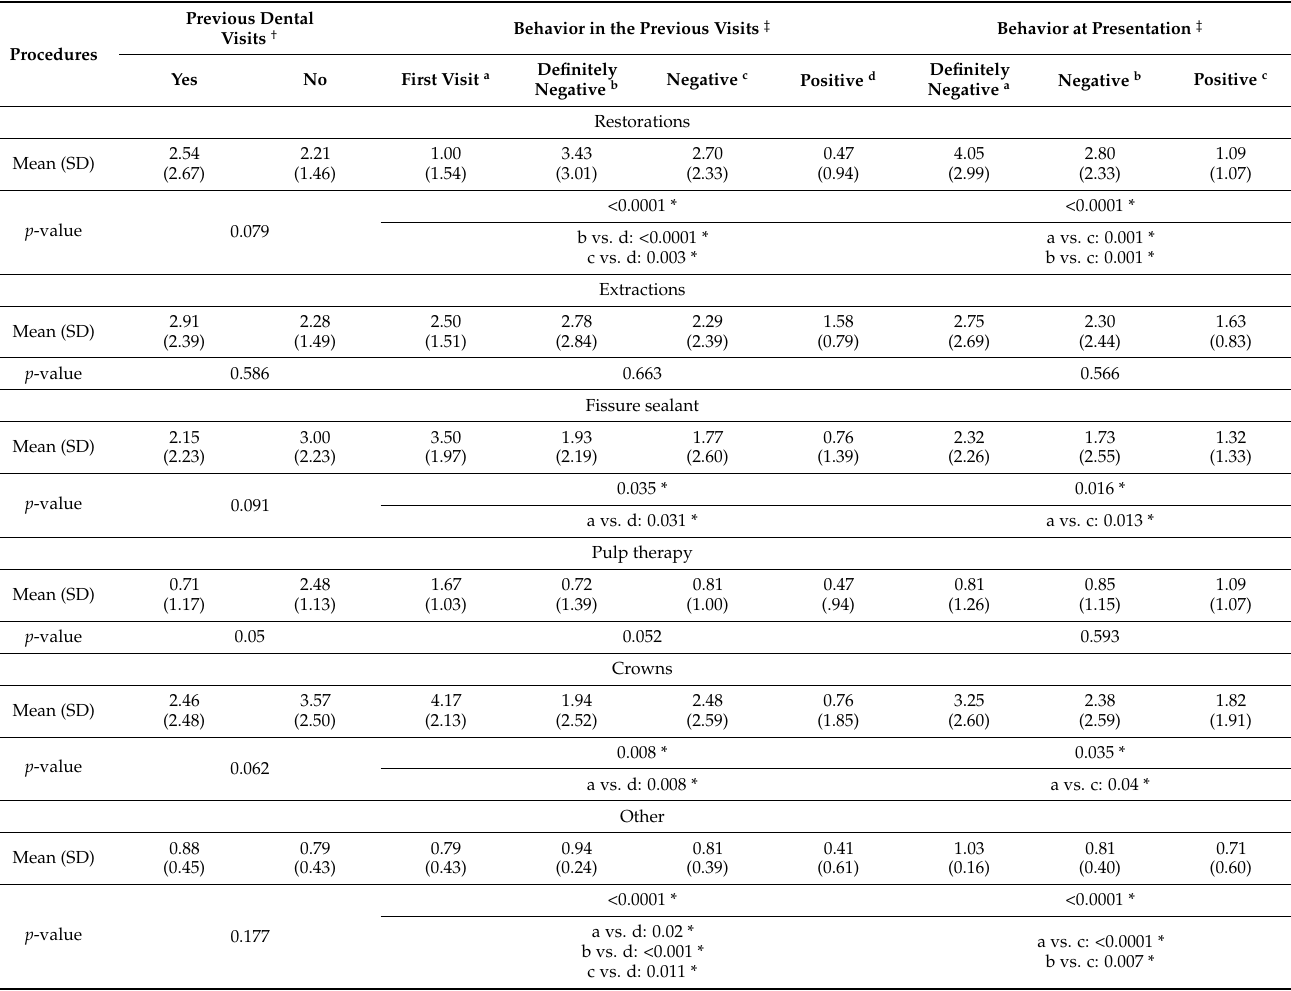
Table 6. The dental procedures provided to ASD children according to previous dental visits and the children’s